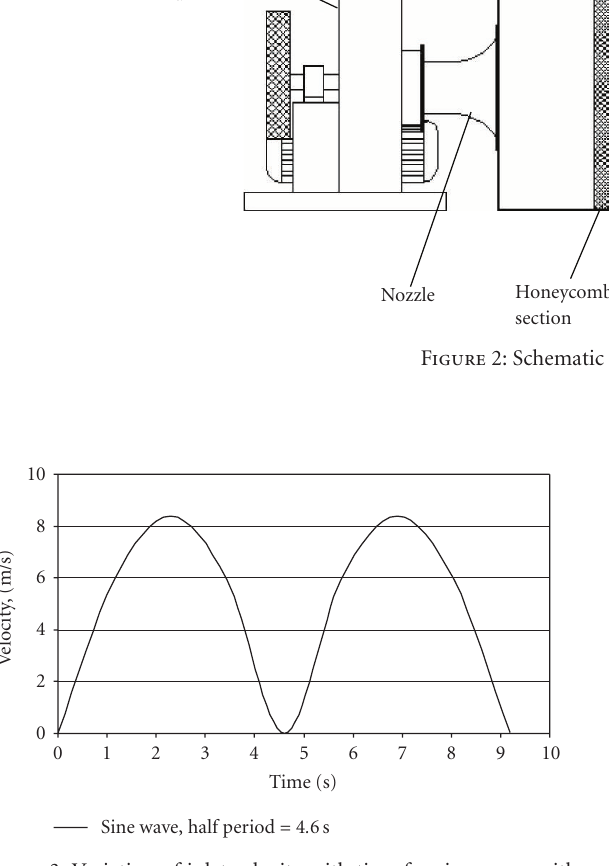
Figure 3: Variation of inlet velocity with time for sine waves with half period of 4.6